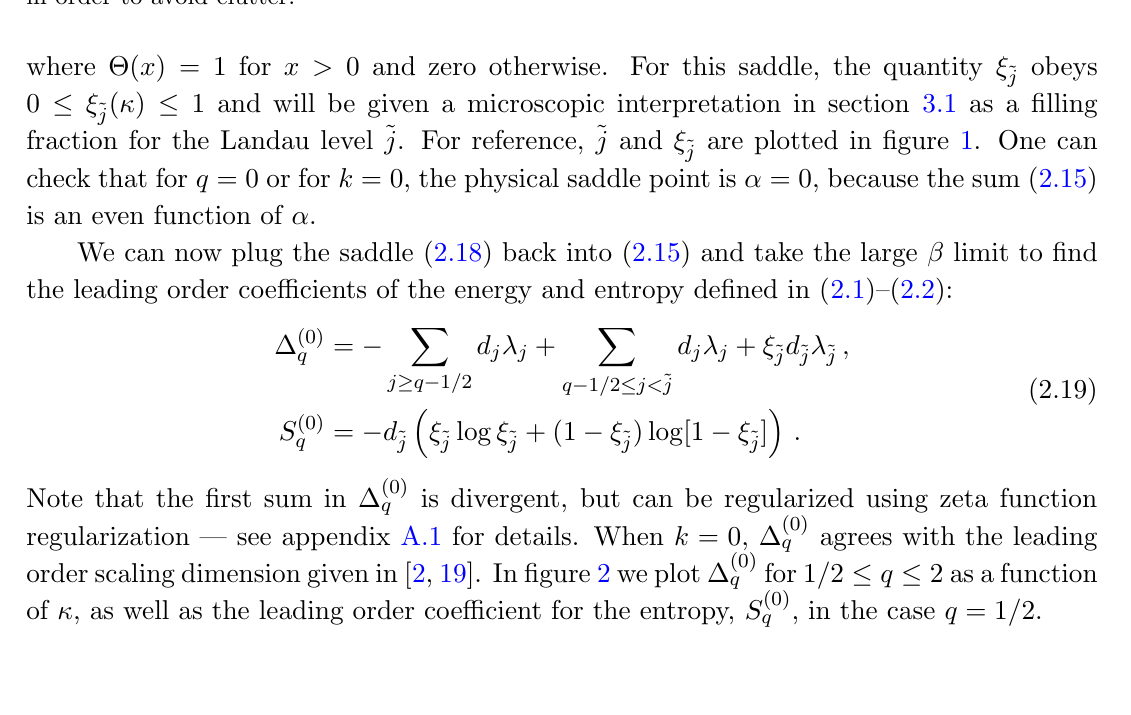
Figure 2 . The leading order coe(cid:14)cients (cid:1) (0) q and S (0) q of the scaling dimension and entropy of the lowest-dimension monopole operators in QED 3 , as a function of (cid:20) (cid:17) k=N . The scaling dimension coe(cid:14)cient is plotted for 1 = 2 (cid:20) q (cid:20) 2, while the entropy coe(cid:14)cient S (0) q is plotted only for q = 1 = 2 in order to avoid